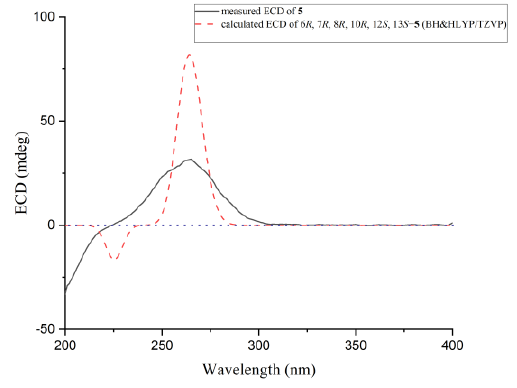
Figure 7. Experimental and calculated ECD of compound 5 .